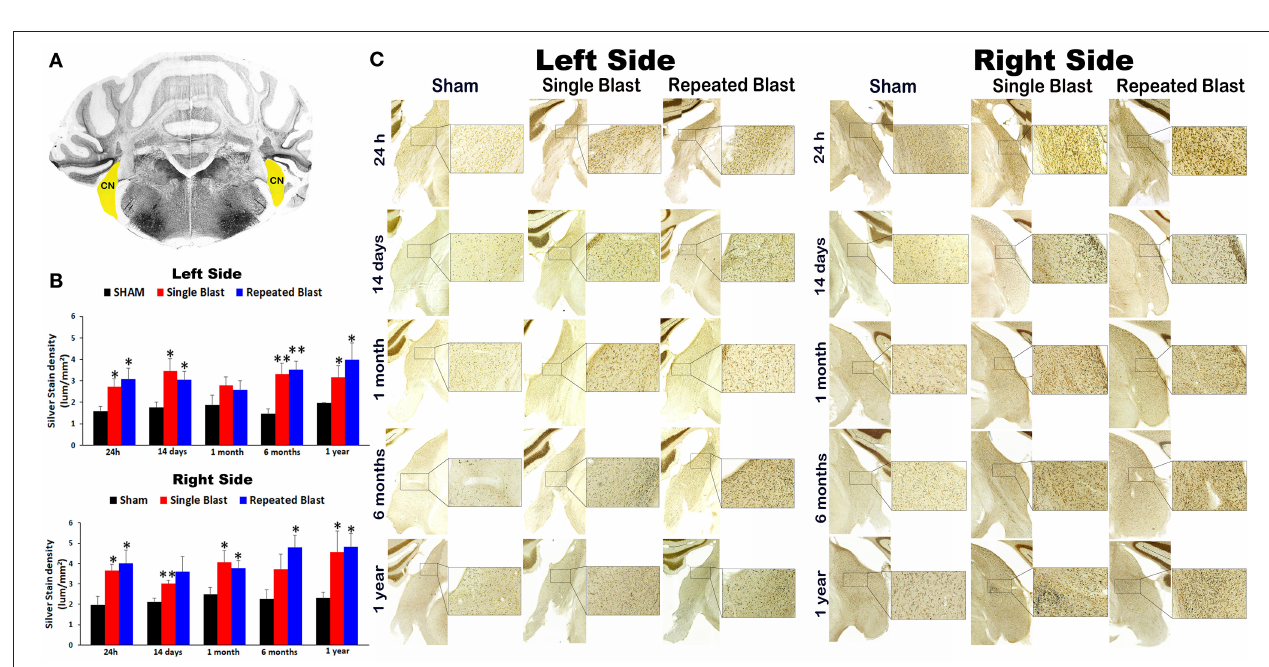
FIGURE 5 | Silver staining in the left and right cochlear nuclei. (A) Cerebellum and brainstem structures showing cochlear nucleus (CN) selected using the rat brain atlas for analysis. (B) Graphics showing densitometry analysis from left and right silver-stained CN at different intervals post-blast exposures. (C) Representative silver-stained images from left and right CN at different intervals after single and tightly coupled repeated blasts. Portions of sections inside rectangles are shown at higher magnification on the right. Values are expressed as mean ± SEM. Density values of single and repeated blast-exposed groups were compared to the respective sham controls (** p < 0.01; * p < 0.05; ANOVA; normal distribution; n = 4–6).